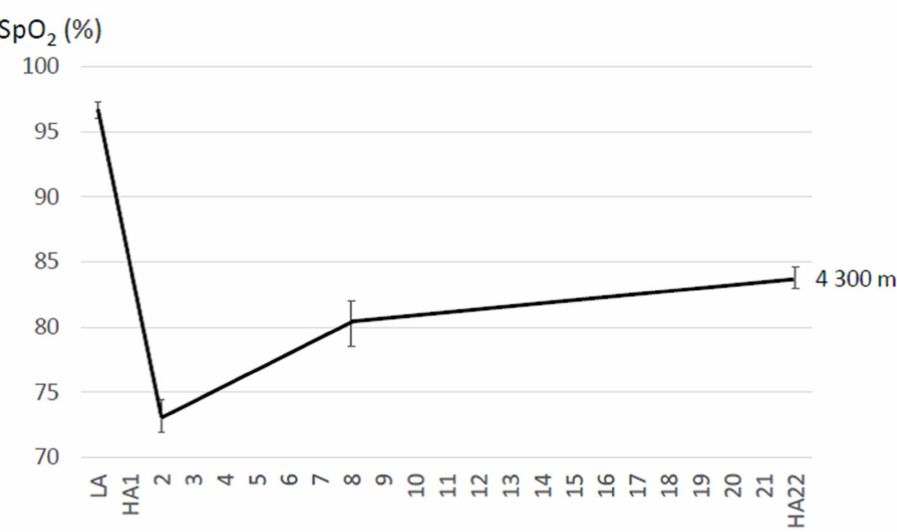
Figure 5. Example for changes of peripheral oxygen saturation (SpO 2 ) during submaximal exercise when acutely ascending from low (LA) to high altitude (HA) and during the subsequent 22-day acclimatization period based on a study performed at 4300 m [68]. Resting SpO 2 was measured in a sitting (upright) position for a 4-min period after relaxing for 20 min, by ear oximetry (Hewlett- Packard 47201A ear oximeter, Palo Alto, CA,